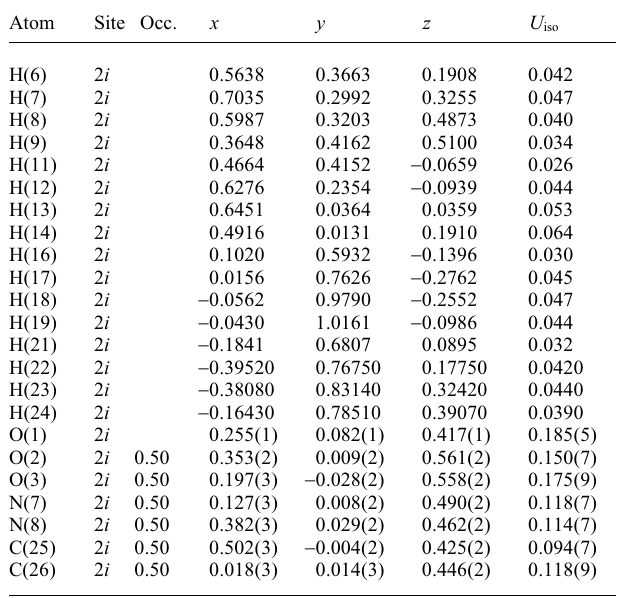
Table 2. Atomic coordinates and displacement parameters (in Å 2 ) .